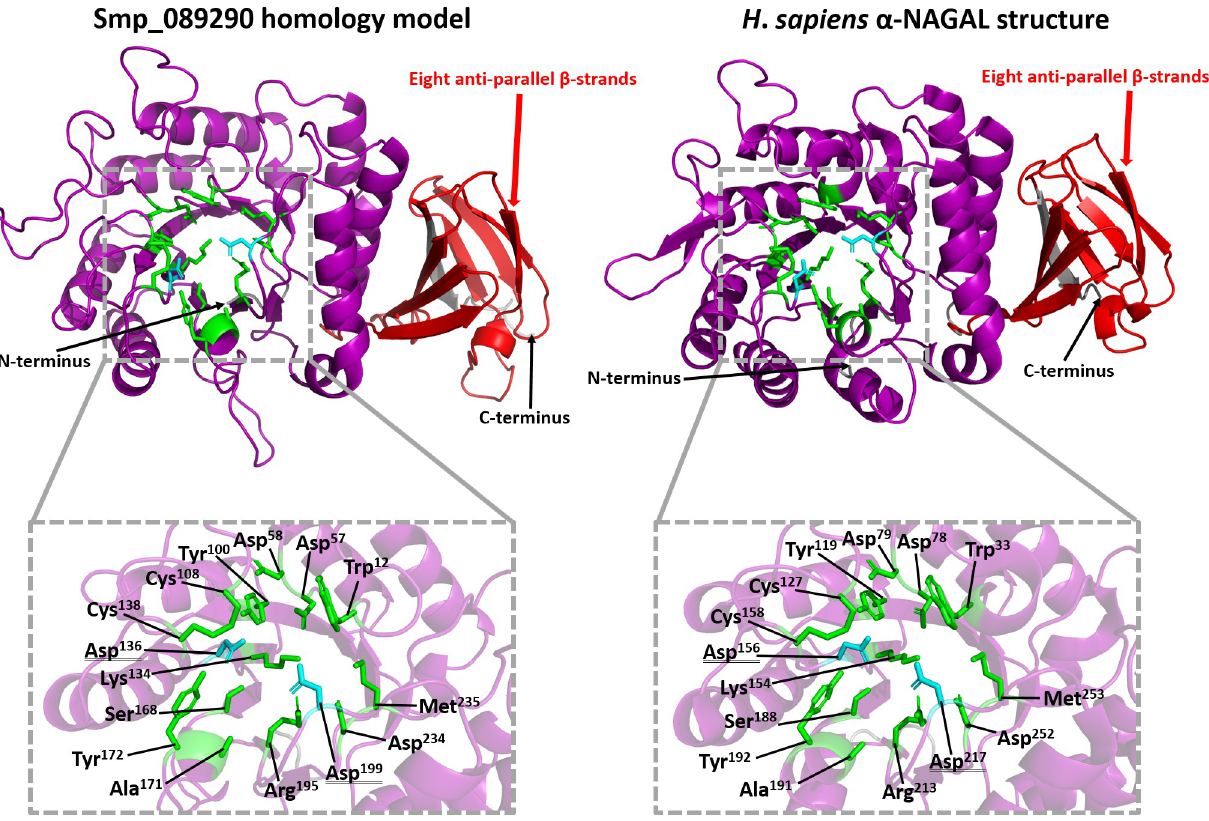
Fig 3. Comparisons of the catalytic active site pockets found in the Smp_089290 homology model and the crystal structure of human α -NAGAL. The grey dashed boxes depict a close-up view of the catalytic active site pocket within the Smp_089290 homology model’s and H . sapiens α -NAGAL crystal structure’s melibiase-2 domain (purple). The close-up views label all 13 ligand binding residues (green) and two catalytic Asp residues (light blue, underlined with double line) with their corresponding amino acid positions in each of the protein sequences shown. The red arrows show the location of the eight anti-parallel β -strands found near the C-terminus of the Smp_089290 homology model’s and the H . sapiens α -NAGAL crystal structure’s melibiase-2 C-terminal domain (red). Black arrows show the locations of the N and C-termini of the model/structure.